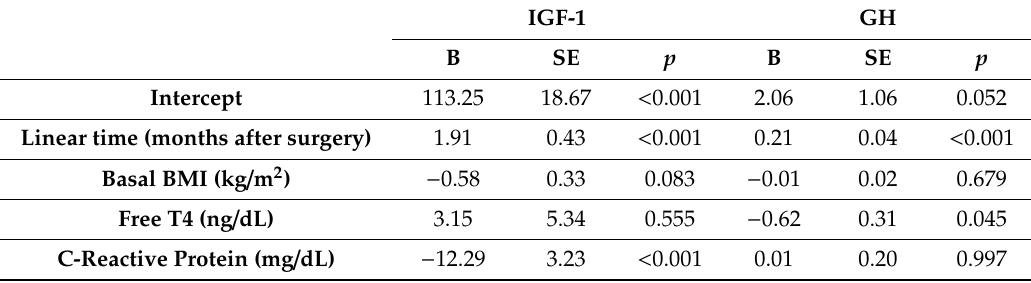
Table 4. Generalized estimating equation model examining change of IGF-1 and GH levels after bariatric surgery, adjusting for basal BMI and free T4 and C-reactive protein values in the follow-up. IGF-1 GH B SE p B SE p Intercept 113.25 18.67 < 0.001 2.06 1.06 0.052 Linear time (months after surgery) 1.91 0.43 < 0.001 0.21 0.04 < 0.001 Basal BMI (kg / m 2 ) − 0.58 0.33 0.083 − 0.01 0.02 0.679 Free T4 (ng / dL) 3.15 5.34 0.555 − 0.62 0.31 0.045 C-Reactive Protein (mg / dL) − 12.29 3.23 < 0.001 0.01 0.20